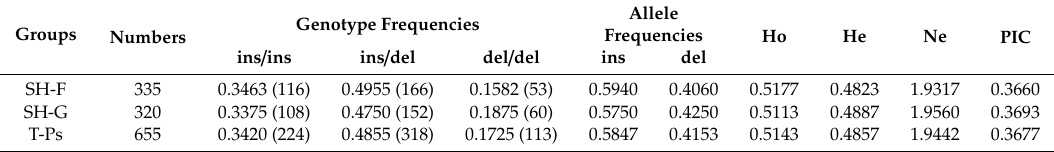
Table 4. Genetic parameters of the VRTN gene g.20311_20312ins291 in Suhuai pig populations.